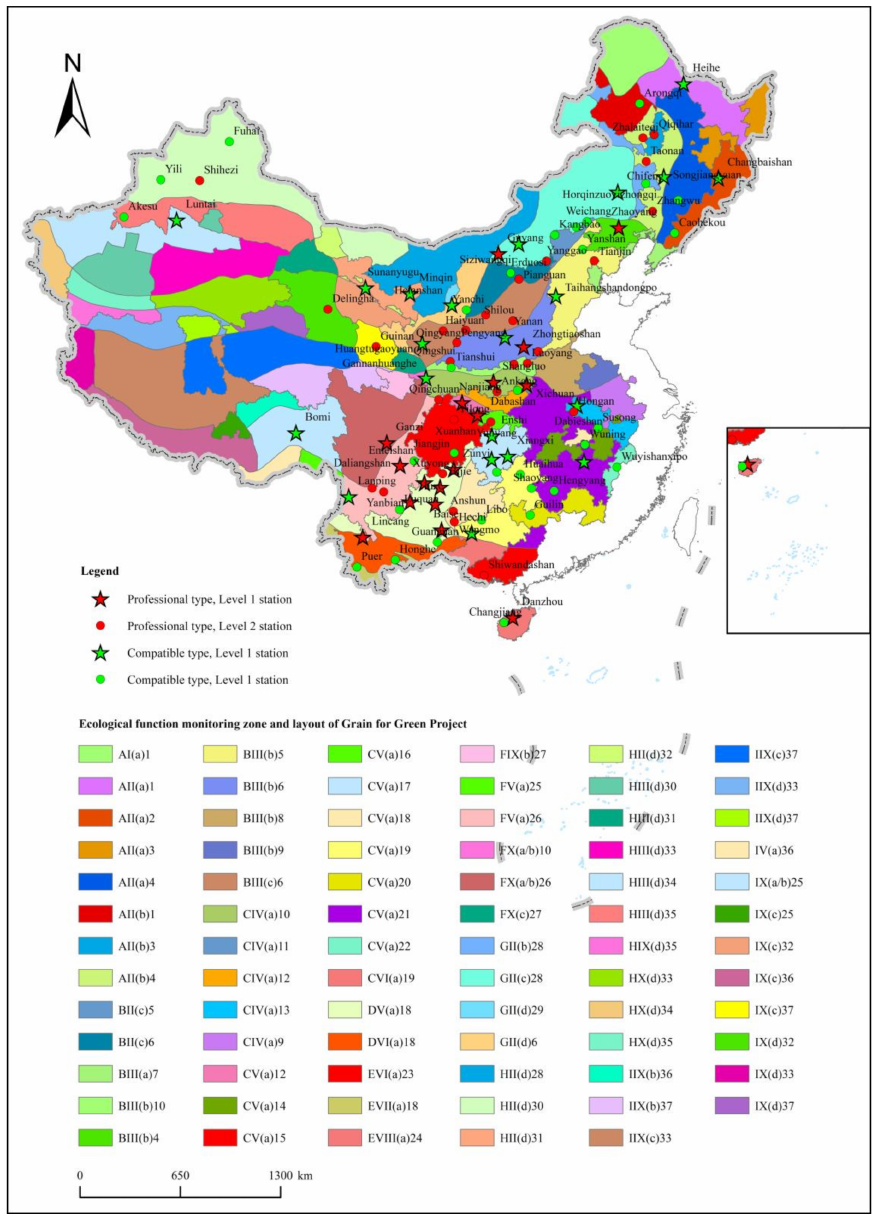
Figure 3. Ecological function monitoring zone and monitoring station layout of the Grain for Green Project (See Table 3 for the meaning of codes in legend